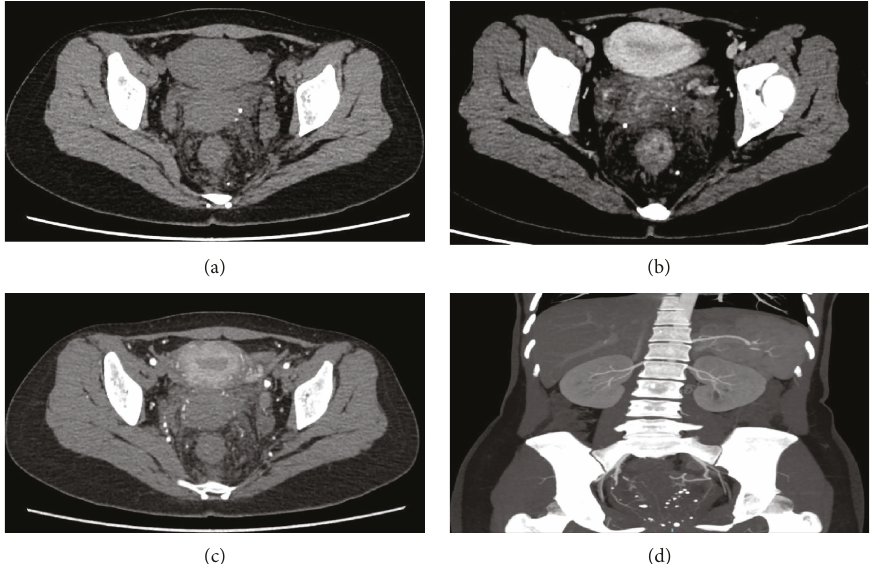
Figure 3: CT fi ndings of DCHR. (a) Thickened rectal wall. (b) Enlarged serpentine vessels in the rectal wall. (c) Multiple calci fi cation. (d) Serpentine vessels and multiple calci fi